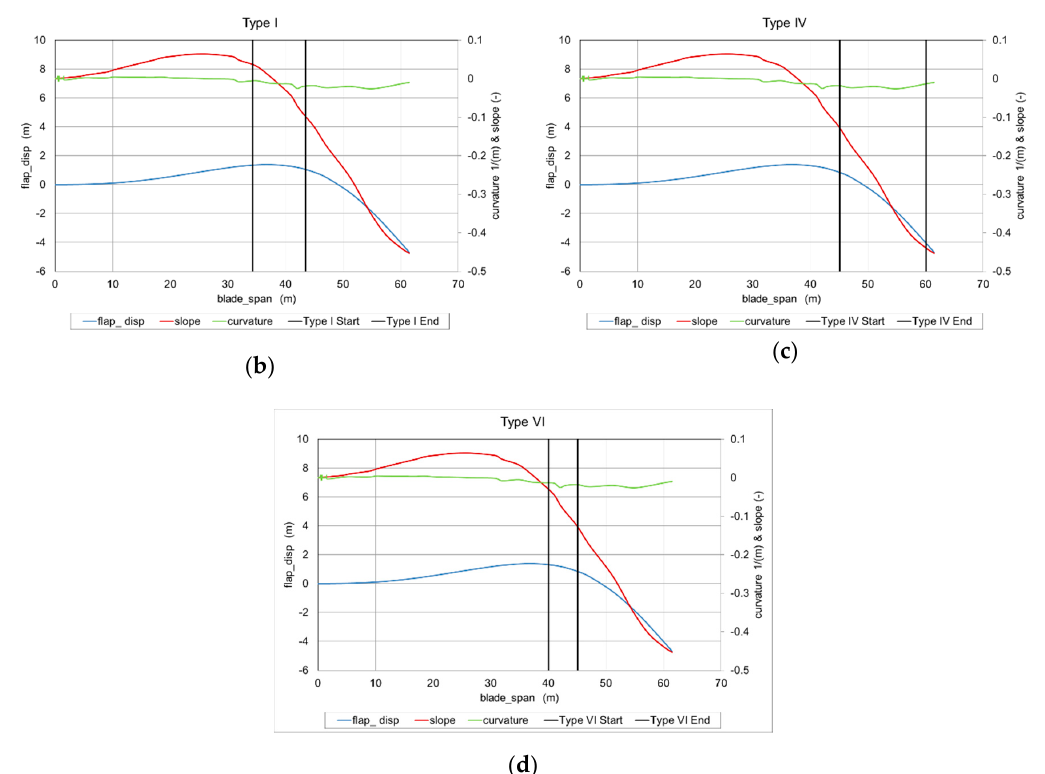
Figure 3. ( a ) Flap deflection, slope, and curvature of the second eigenmode of the considered WT blade, ( b ) location of tip accumulator of type I, ( c ) location of tip accumulators of type IV, and ( d ) location of tip accumulators of type VI .